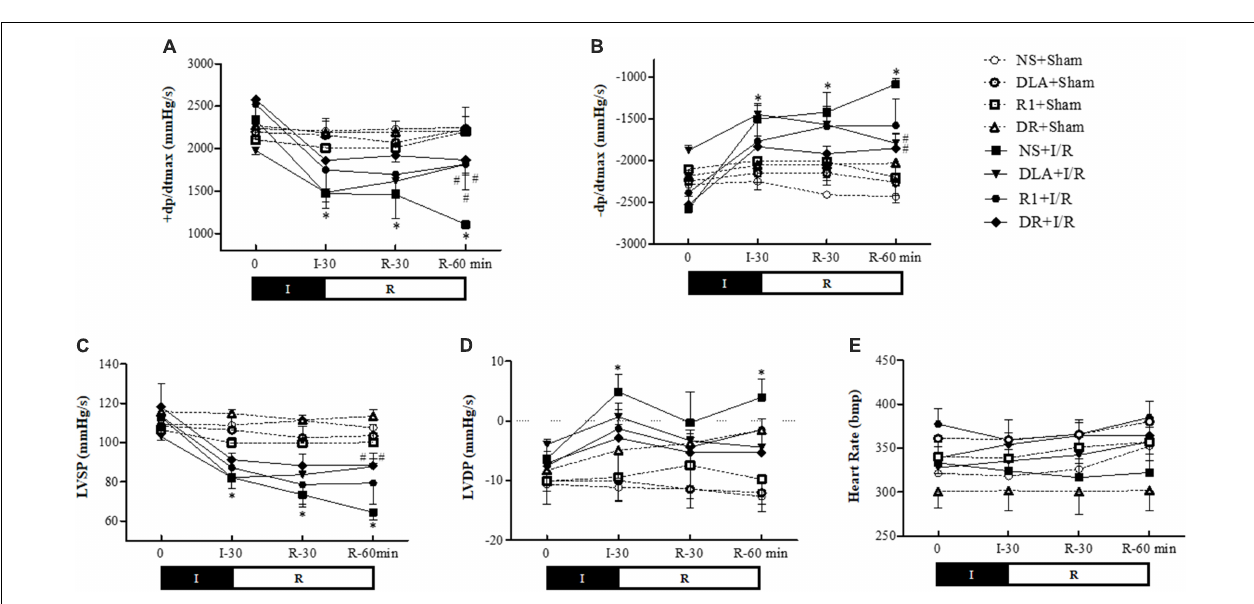
FIGURE 4 | The effect of DR pretreatment on the rat heart function. Presented are the time courses of +dP/dtmax (A) , –dP/dtmax (B) , left ventricular systolic pressure (LVSP) (C) , left ventricular diastolic pressure (LVDP) (D) , and heart rate (HR) (E) , in different groups. The linear mixed-effect models were analyzed for repeated measurement data, and least-squares means were calculated between the groups at different time points. Values are means ± SEM ( n = 6). I, ischemia phase; R, reperfusion phase. * p < 0.05 vs. NS + Sham group; # p < 0.05 vs. NS + I/R